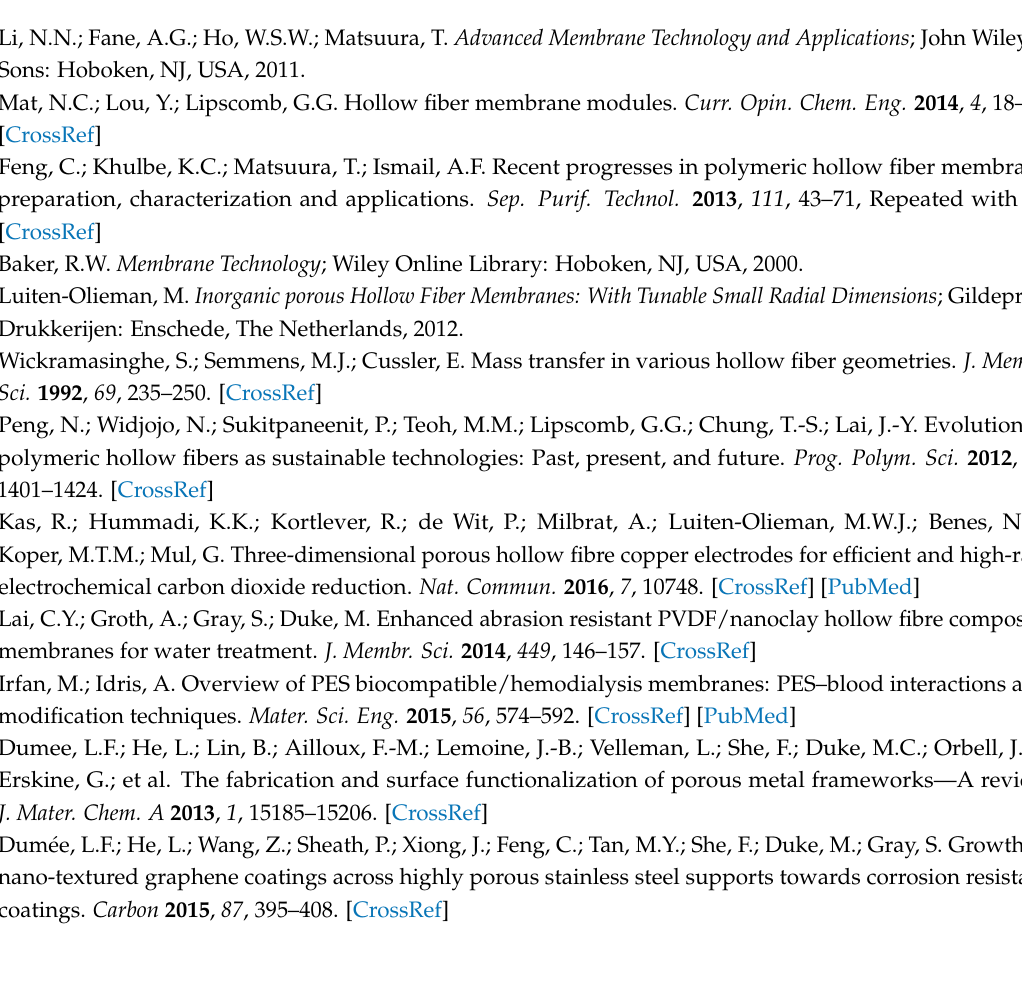
Figure S1: Thermal treatment and TGA profile of the green SS 10 HF in air atmosphere with a heating rate of 10 ◦ C.min -1 , Figure S2: SEM images of the green and sintered SS 10 HFs at temperature ranging from 650 to 1100 ◦ C for 60 or 90 min, Figure S3: SEM images of the green and sintered SS 10/20 HFs at temperature ranging from 650 to 1100 ◦ C for 60 or 90 min, Figure S4: SEM images of the green and sintered SS 10/44 HFs at temperature ranging from 650 to 1100 ◦ C for 60 or 90 min, Figure S5: Carbon and oxygen elemental analysis of the SS 10 HFs (a and d), SS 10/20 HFs (b and e) and SS 10/44 HFs (c and f), Figure S6: Pure water fluxes as a function of the feed pressure: (a), (b) and (c): SS 10 HFs; (d), (e) and (f): SS 10/20 HFs; g: SS 10/44 HFs; Table S1: Size distribution of stainless steel particles, Table S2: Metal powder properties: surface area, total BET surface area, average absolute density and relative density determined versus average bulk density of 316L grade stainless steel (8 g.cm -3 ), Table S3: Spinning